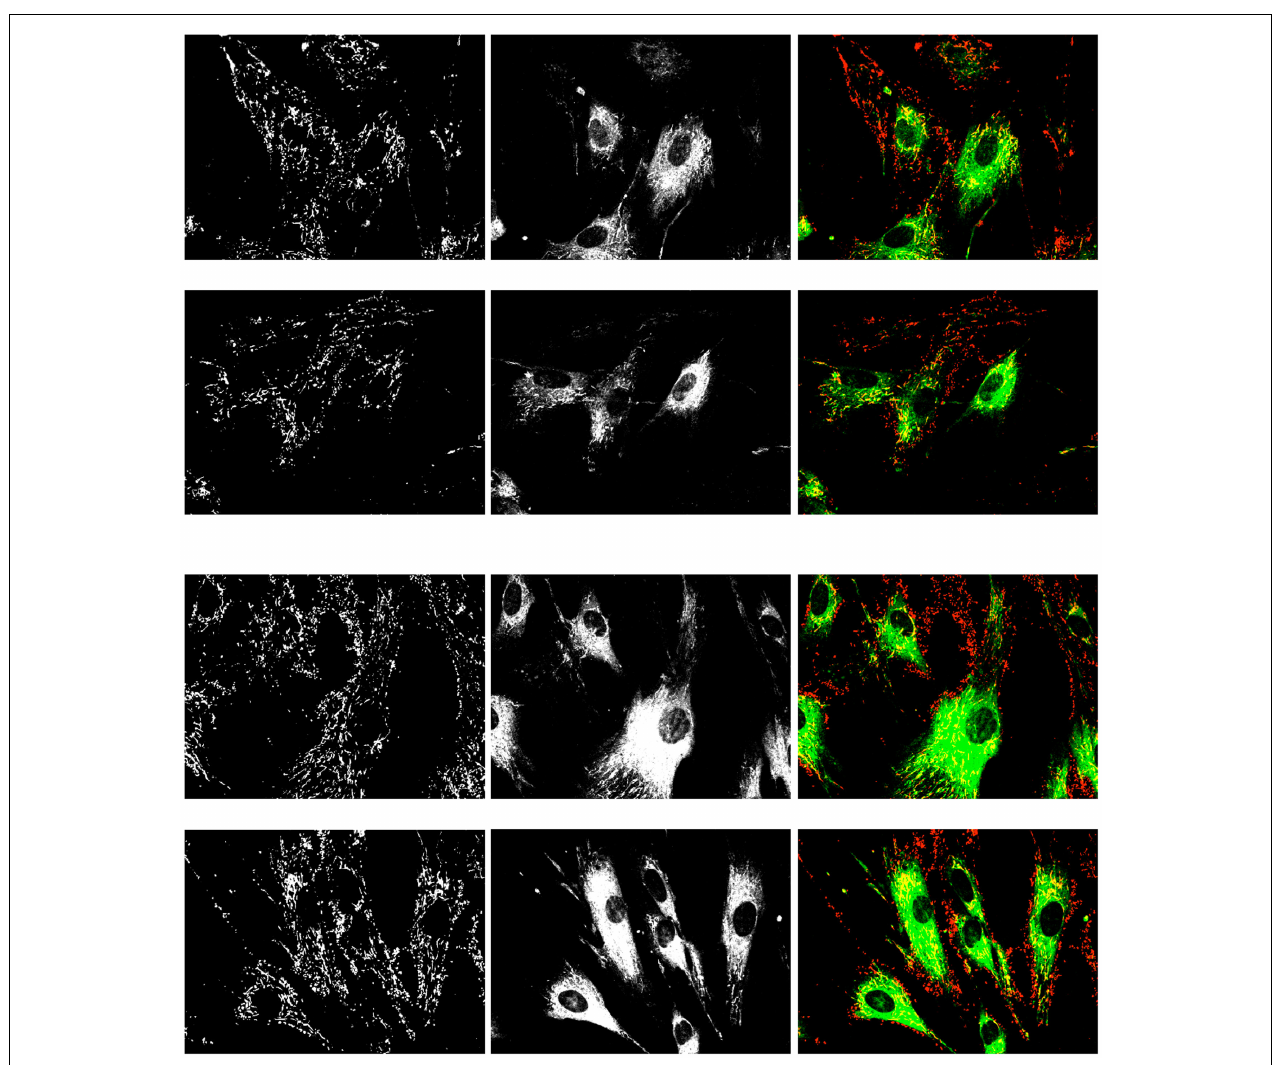
under identical conditions, and are representative of numerous fields viewed and imaged.The increase in the monomeric, green form of the dye is indicative of a depolarization of the mitochondrial inner membrane.Treated cells had a 30% higher mean pixel intensity than control cells (143 ± 14 vs. 110 ± 10) in the monomeric form of the dye ( p <